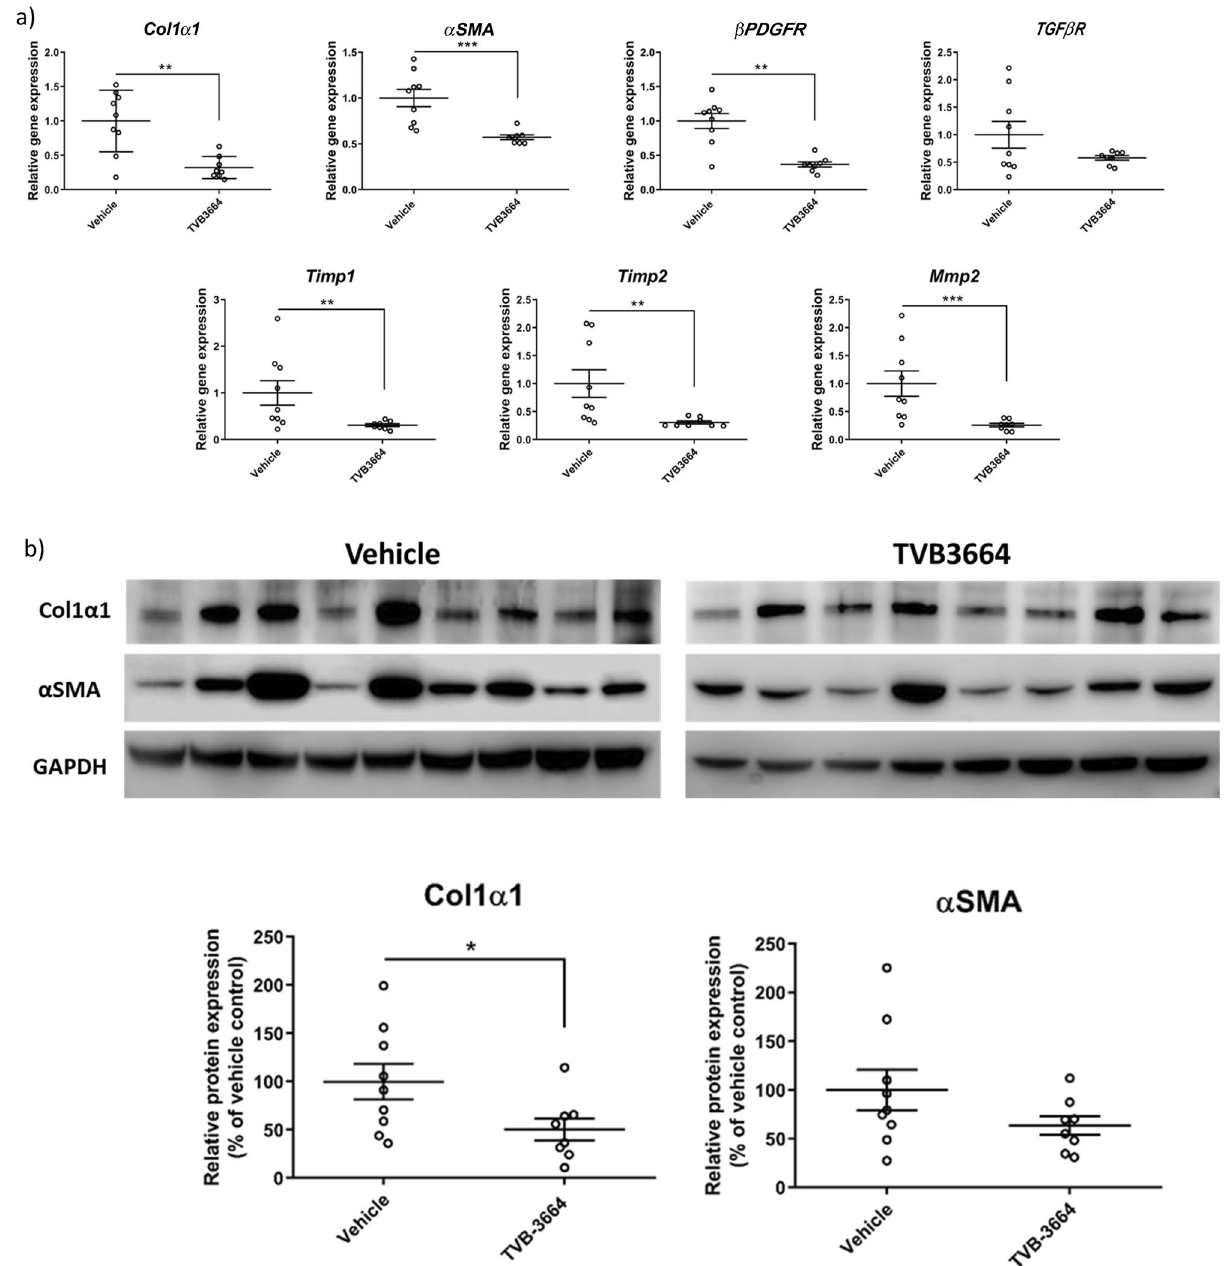
Figure 5. Gene and protein expression, and NAS score in the FAT-NASH (CCl 4 ) Model. ( a ) Effect of FASNi on mRNA expression of fibrogenic genes. liver tissues measured by RT-qPCR treated with vehicle or TVB- 3664 (5 mg/kg). ( b ) Effect of FASNi on protein expression of fibrogenic genes. Western blot analysis of protein expression of Col1A1 and αSMA in liver tissue from animals treated with vehicle or TVB-3664. ( c ) Effect of FASNi on liver histology by H&E. Representative photomicrographs of H&E stained liver sections in vehicle (PEG400) and TVB-3664. Steatosis (yellow arrow), hepatocyte ballooning (red arrow) and lobular inflammation (black arrow) are indicated. Statistical analysis was by unpaired two tailed Mann–Whitney test. *p ≤ 0.05 vs vehicle group. ( d ) Effect of FASNi on liver histology by NAS score Analysis performed blinded at the end of treatment with vehicle or TVB-3664. Lines represent Mean/SD. ( e ) Effect of FASNi on plasma AST, ALT, total cholesterol and triglycerides. Lines represent Mean/SD. Statistical analysis was by unpaired two tailed